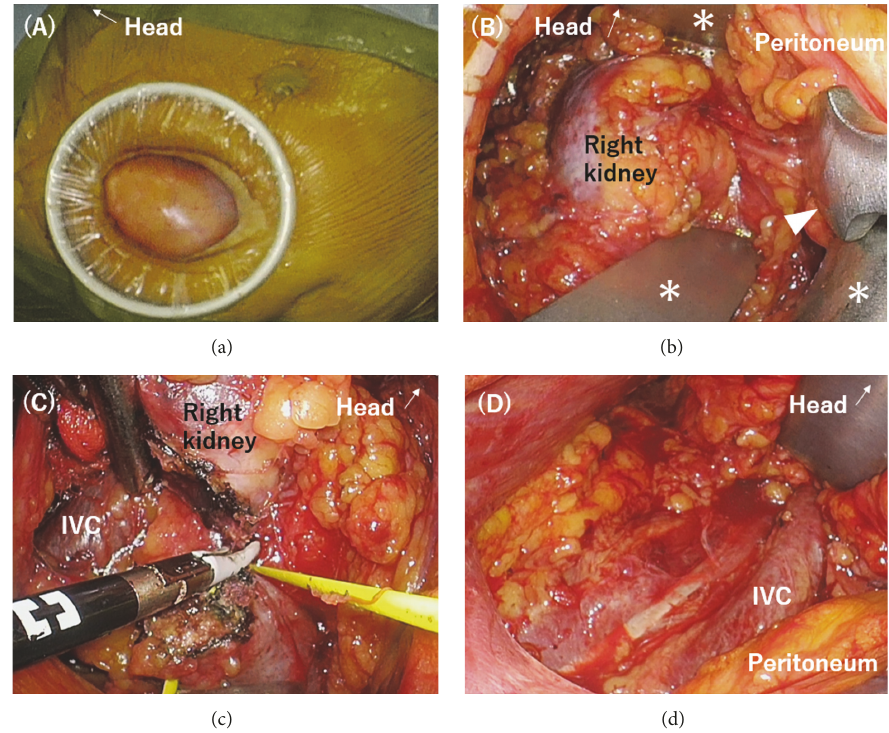
Figure 2: (a) A wound retractorwas placed at the pararectal incision of 6 cm made in the right upper quadrant. (b) Nephroureterectomywas carried out by keeping the retroperitoneal working space made along the anatomical plane using the Omni-Tract retractor system and PLES retractors (an arrow head). Asterisks indicate blades of the Omni-Tract retractor system. (c) Isthmusectomy was conducted using a bipolar sealing device. A vessel loop was passed beneath the isthmus. (d) The right retroperitoneal after completion of right nephroureterectomyand isthmusectomy. A drain tube was placed here after extensive saline irrigation.